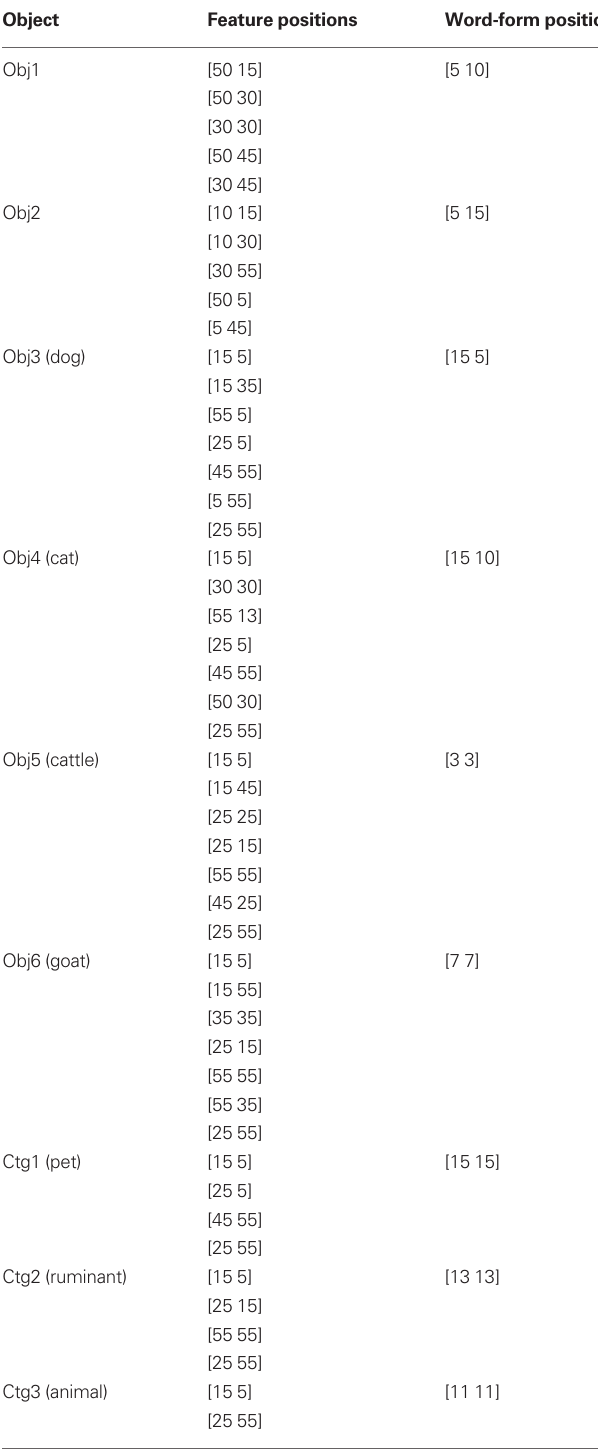
Table 1 | Position of the features in the semantic network for the six simulated objects (second column), and position of the corresponding word-forms in the lexical network (third